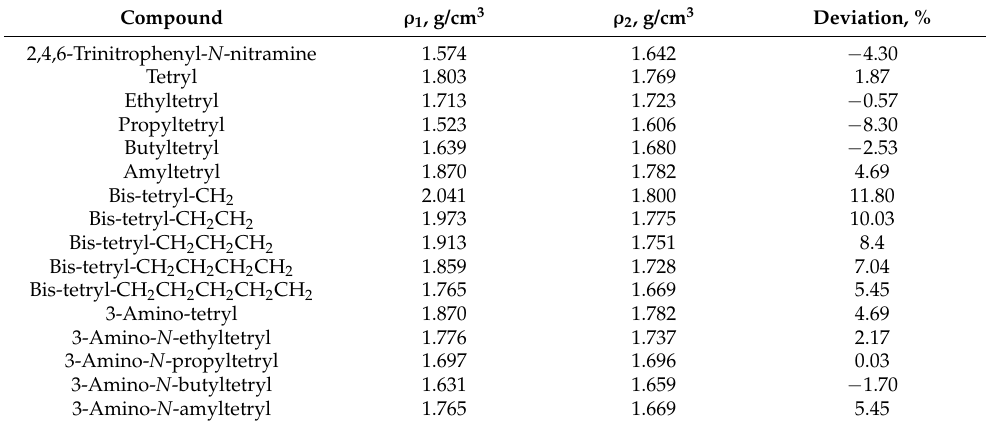
Table A1. The values of density for the studied compounds, obtained using the approach implemented in the ACD/Labs program (denoted as ρ 1 ) and that suggested by M.S. Keshavarz (denoted as ρ 2 ).